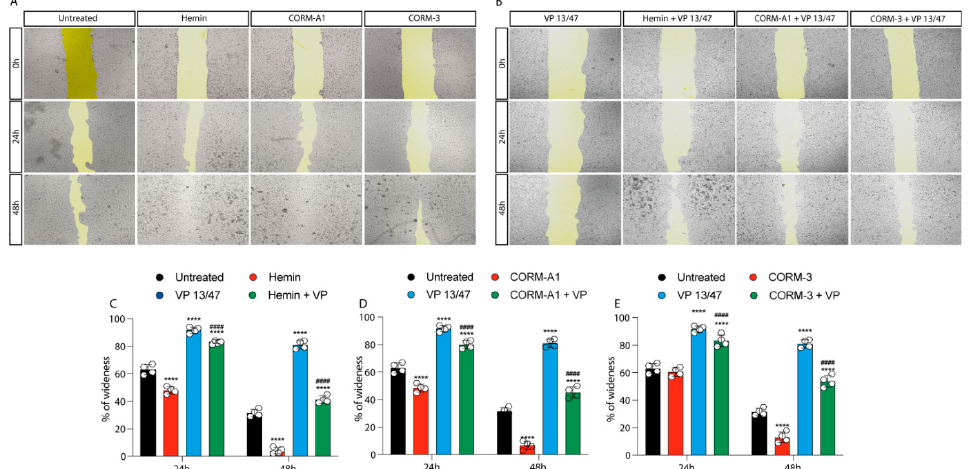
Figure 3. Hemin and CORMs increase 92.1 wound healing ability. ( A ) 92.1 supplemented with Hemin (10 µ M), CORM-A1 (25 µ M), and CORM-3 (25 µ M) increase their wound closure speed. The differences are already visible 24 h post-treatment. ( B ) VP 13/47 (50 µ M) impairs Hemin- and CORMs- induced 92,1 wound closures. The opening of the wound is drastically affected by VP 13/47 supplementation, eventually hampering hemin, CORM-A1, and CORM-3-induced closure. Quantification of the percentage of wideness resulting from ( C ) Hemin (10 µ M), ( D ) CORM-A1 (25 µ M), and ( E ) CORM-3 (25 µ M) supplementation. The three molecules, once administered, increase 92.1 wound closure. Their effect is disrupted by VP 13/47 (50 µ M) addition. Each result is representative of four different replicas (mean ± SD). p values <0.05 were statistically significant **** p <0.0001 vs. untreated. #### p < 0.0001 vs. ( C ) Hemin, ( D ) CORM-A1, and ( E )